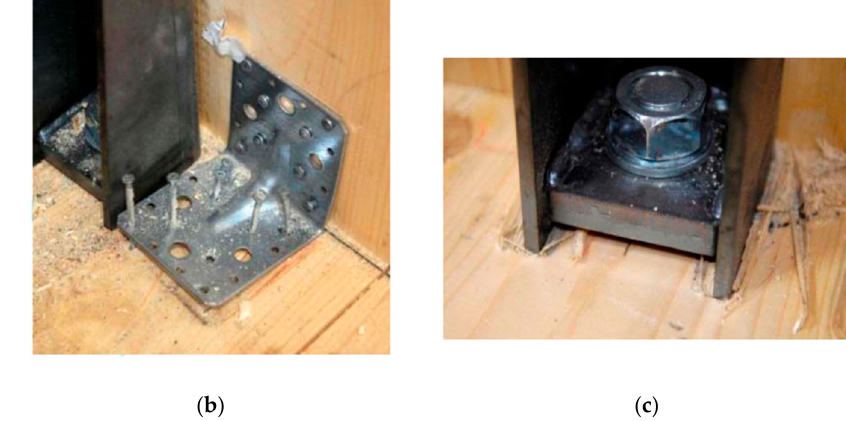
Figure 3. Failure modes of a seven-storey CLT building in shake table testing: ( a ) out-of-plane bending of hold-down; ( b ) pulling-out of nails in angle brackets; ( c ) embedment of a connector [16].